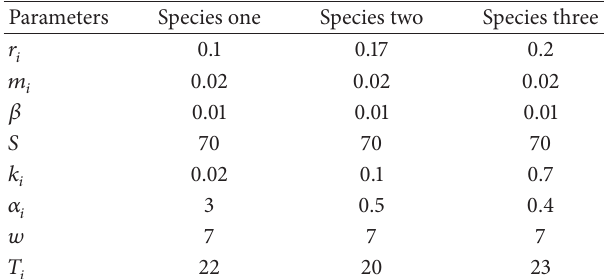
Table 1: Parameters used in